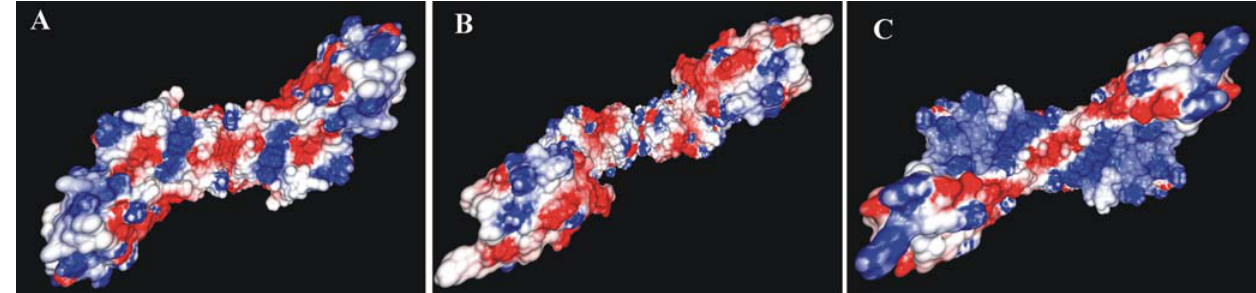
Figure 4. Electrostatic surface potential calculation. GRASP2 [51,52] electrostatic surface potentials within the DNA-binding grooves calculated for equivalent N-terminal fragments of: (A) S. pneumoniae ParC (ParC55), (B) E. coli ParC, (C) E. coli GyrA. The E. coli ParC structure was manually brought into the ‘closed’ conformation, but the experimentally determined fold of the active site was preserved. Negatively charged surfaces are in red and positively charged surfaces are in